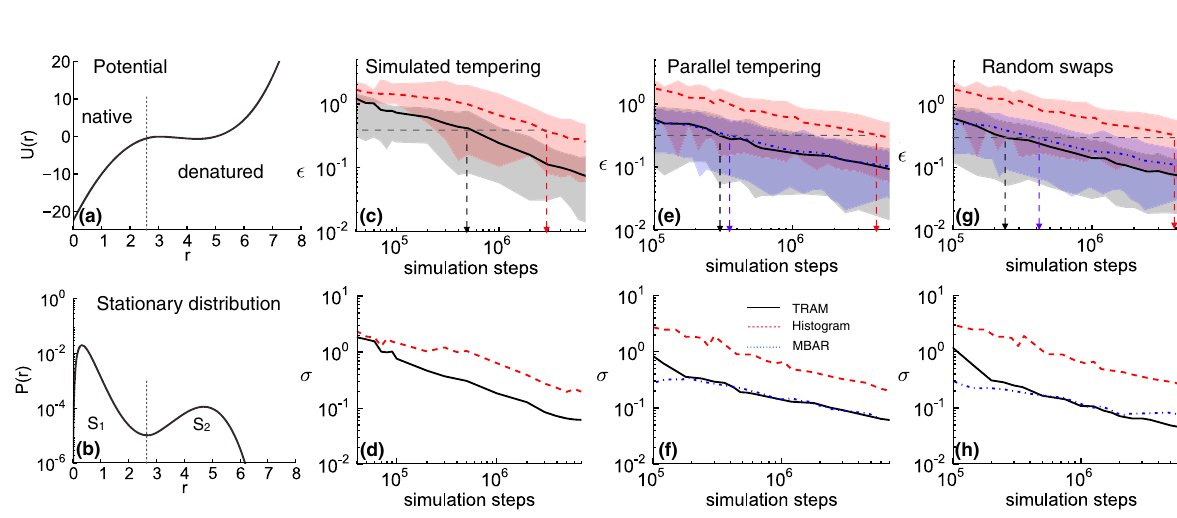
T . Results are shown in terms of the relative FIG. 3. (a) Potential U ð r Þ . (b) Corresponding stationary distribution at ð 1 = β Þ ¼ 1 . 1 k B error ϵ of the probability of being in the “ denatured ” state versus the number of simulation steps required. (c, d) Results of the ST simulation. (c) xTRAM estimate (black, continuous line) and direct counting estimate (red, dashed line). Arrows indicate an ϵ ¼ 0 . 3 error level (d) standard deviation of the 100 realizations (c) for both estimators. (e, f) Results of the parallel tempering simulation. (e) MBAR estimate (blue, dashed-dotted line), with arrows indicating the ϵ ¼ 0 . 2 error level. (f) Standard deviation of data in (e) from 100 realizations. (g, h) Comparison of the RS þ xTRAM estimate to the PT estimate using MBAR and direct counts in (e). Arrows indicate the ϵ ¼ 0 . 2 error level. (h) Standard deviation of the data in (g) over 100